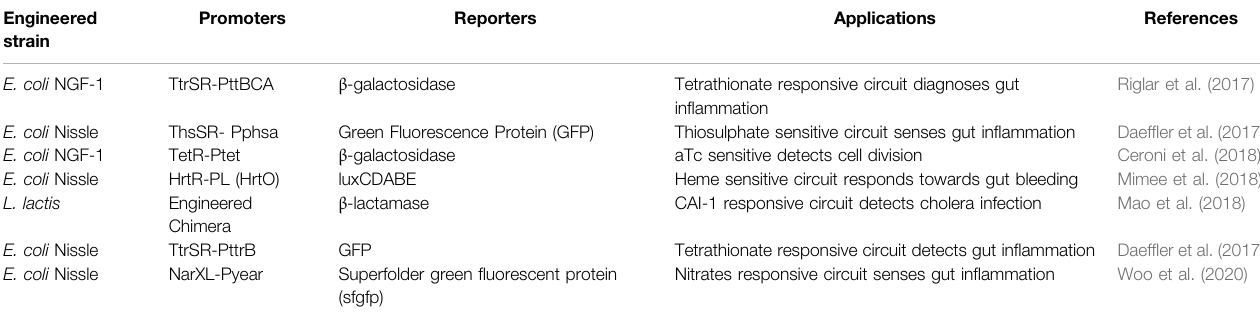
TABLE 1 | List of promoters used in